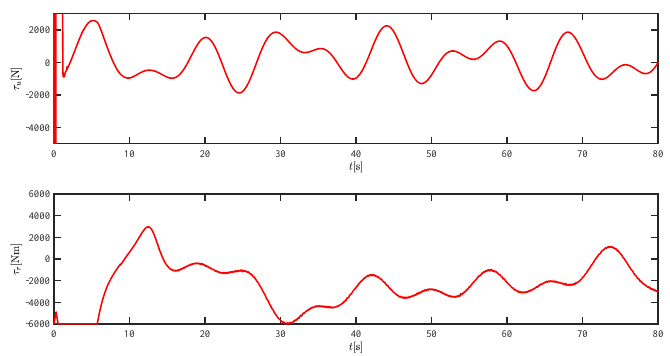
Figure 26. The lumped disturbances and their estimations at fast speed.